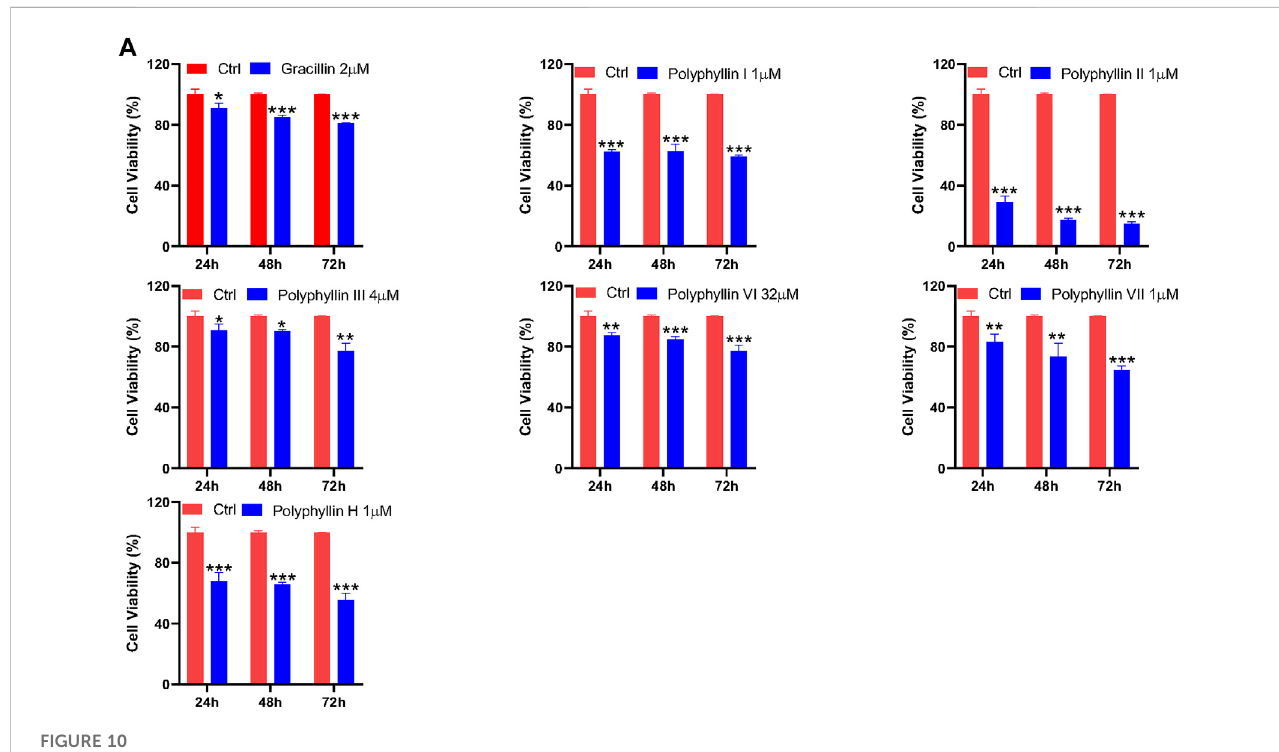
(Figure 7A, right circle), and 12 EMT-LUAD-Chonglou related genes were identi fi ed (Figure 7A, the overlapping